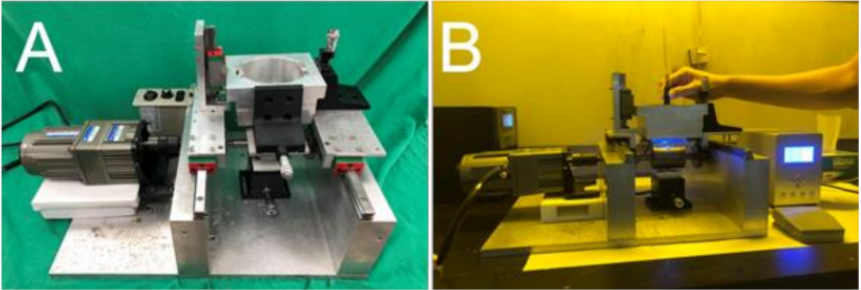
Figure 2. Photos of an ( A ) ultraviolet (UV) soft mold roller embossing device, ( B ) UV soft mold embossing